Question: What caption would you write for this figure?
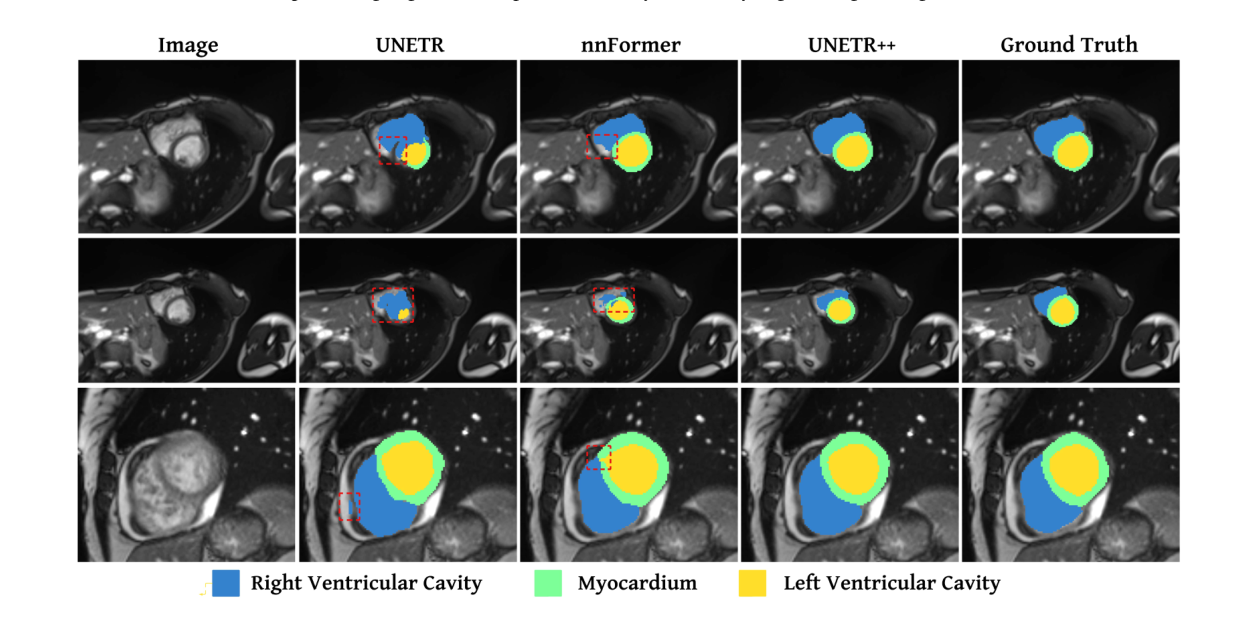
Answer: Qualitative comparison on the ACDC dataset. We compare our UNETR++ with existing methods: UNETR and nnFormer. It is noticeable that the existing methods struggle to correctly segment different organs (marked in red dashed box). Our UNETR++ achieves favorable segmentation performance by accurately segmenting the organs. Best viewed zoomed in.